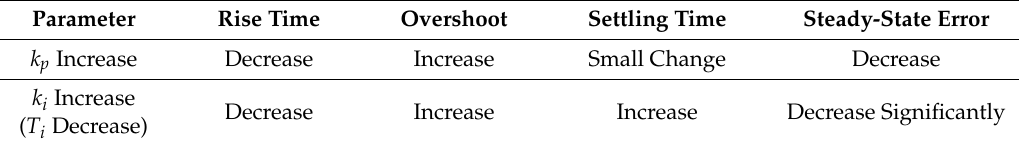
Table 1. The effect of the proportional integral (PI) controller gain value on the system. Parameter Rise Time